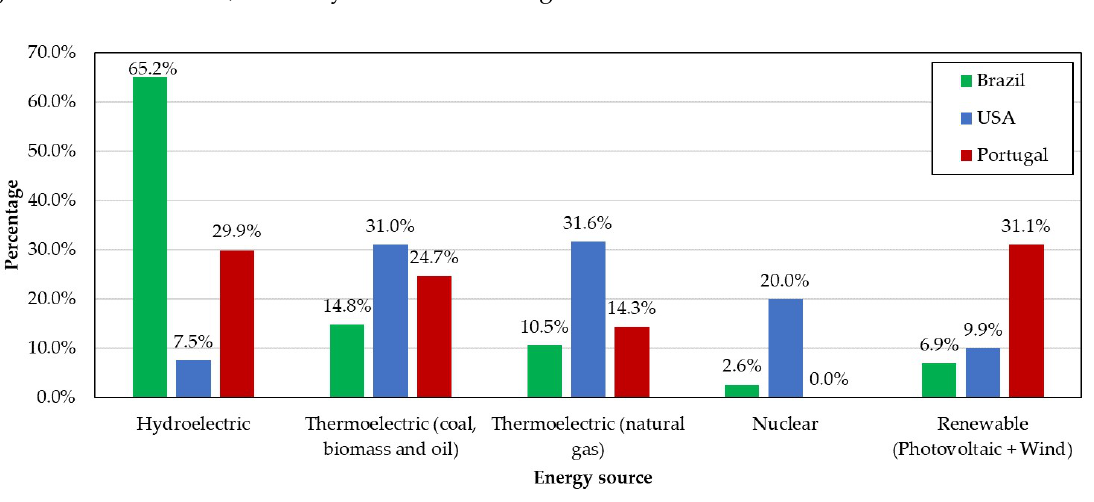
Figure 6. Electricity Generation types in Brazil, USA and Portugal.